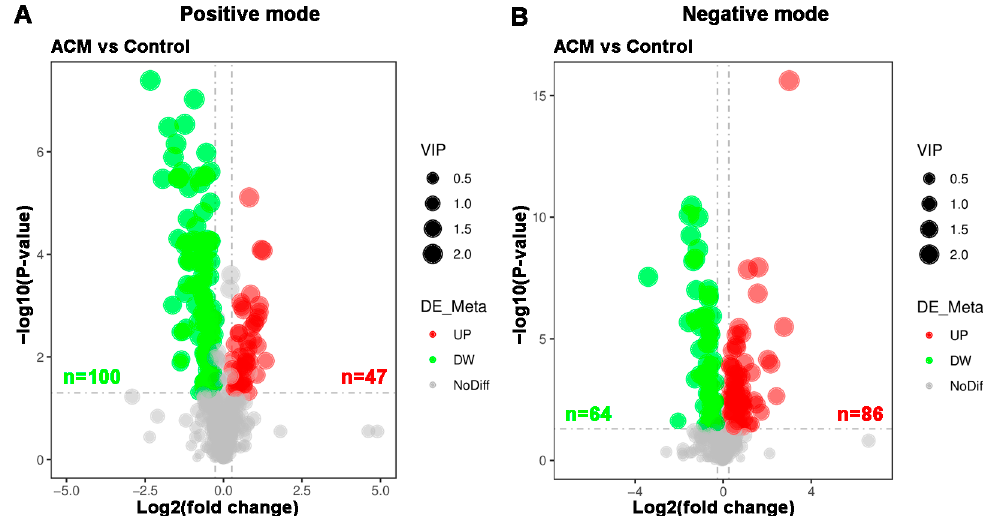
Figure 5. Volcano plots of myocardial metabolomics data between the control and ACM groups. ( A ) Positive mode; ( B ) negative mode. Red represents upregulated metabolites, green represents downregulated metabolites, and gray represents metabolites with no difference between the two groups. The variable importance in projection (VIP) values represent the most important metabolites obtained in the PLS-DA model.